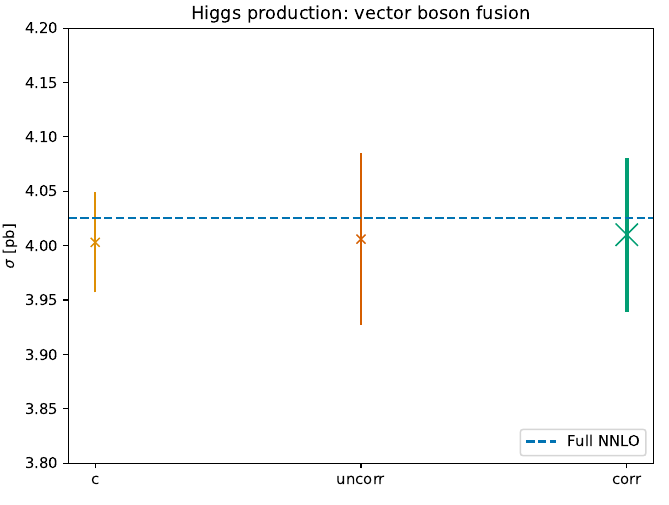
Figure 10 . The same as figure 9 but for Higgs production by vector boson fusion at 13